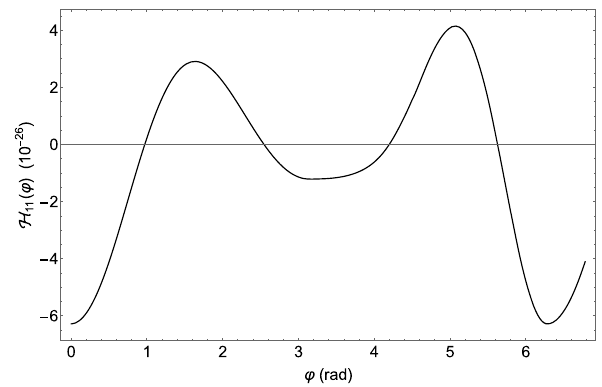
Fig. 2 Gravitational waveform H 11 as a function of the azimuthal angle ϕ . The ϕ -intercepts occurr at ϕ = 0 . 31 π, 0 . 81 π, 1 . 34 π, 1 . 79